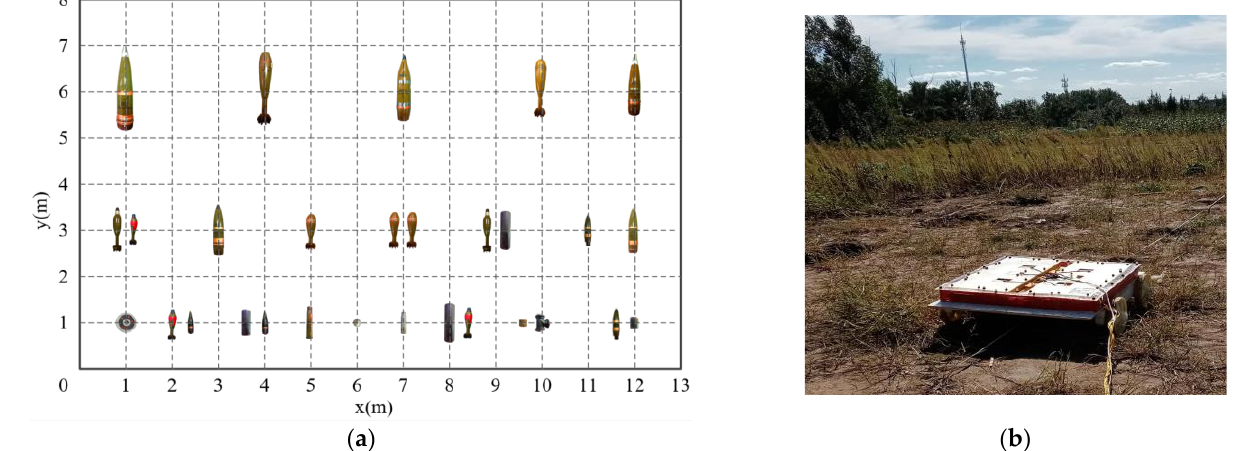
1 Table 3. Parameters of harmless targets.